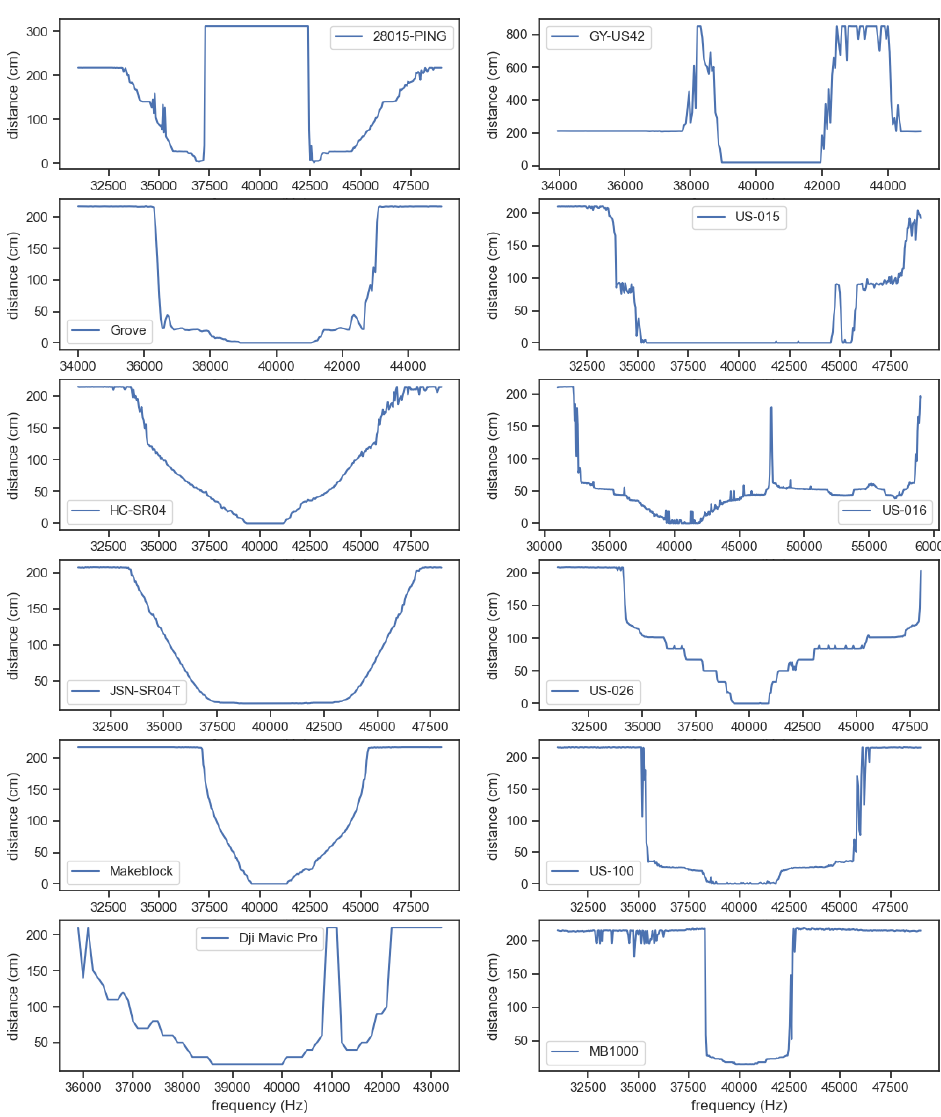
Figure 9. Graphs presenting the attack characteristics; i.e., distance measured by each of the 12 examined sensors for the different attacking signal frequencies. Each sensor can be identified by the label of each